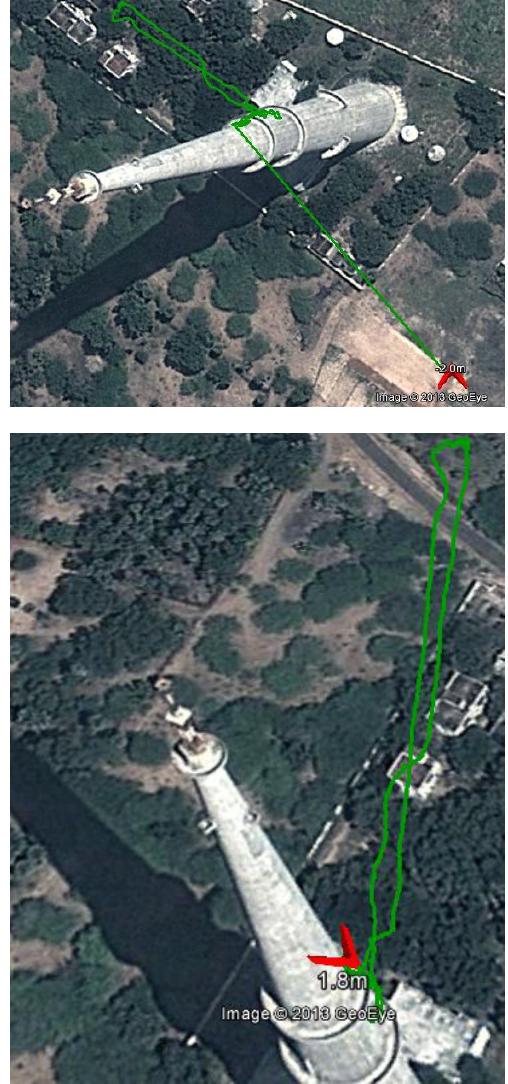
Figure 13. Tower testing:UAV Mission